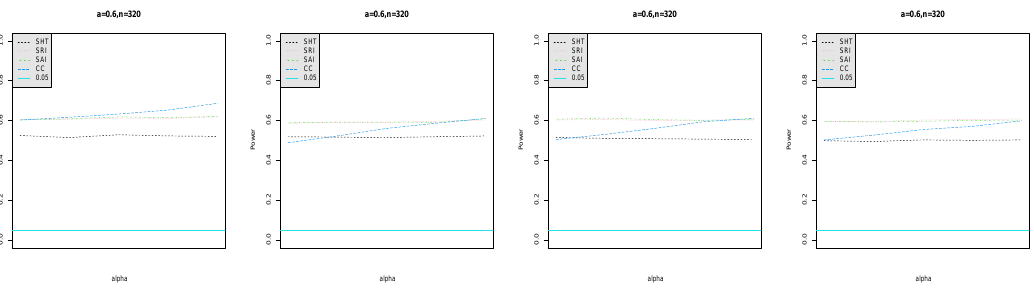
Figure A6. SHT, SRI, SAI and CC represent empirical powers evaluated from IPW, regression imputation, AIPW and CC methods against treatment effect α E 1 for missingness data mechanism models E1 (left panel), E2 (left second panel), E3 (right second panel) and E4 (right panel) for ( a , n ) = (0.2,200) (the first row), (0.2,320) (the second row), (0.6,200) (the third row), and (0.6,320) (the last row) under the unbalanced designs with n E : n R : n P = 2:1:1. Figure A7 presents empirical powers against the tilting parameter γ for three missing- ness data mechanism models E2–E4 under balanced design. Figure A8 presents empirical powers against the tilting parameter γ for three missingness data mechanism models E2–E4 under unbalanced design with n E : n R : n P = 2:1:1.